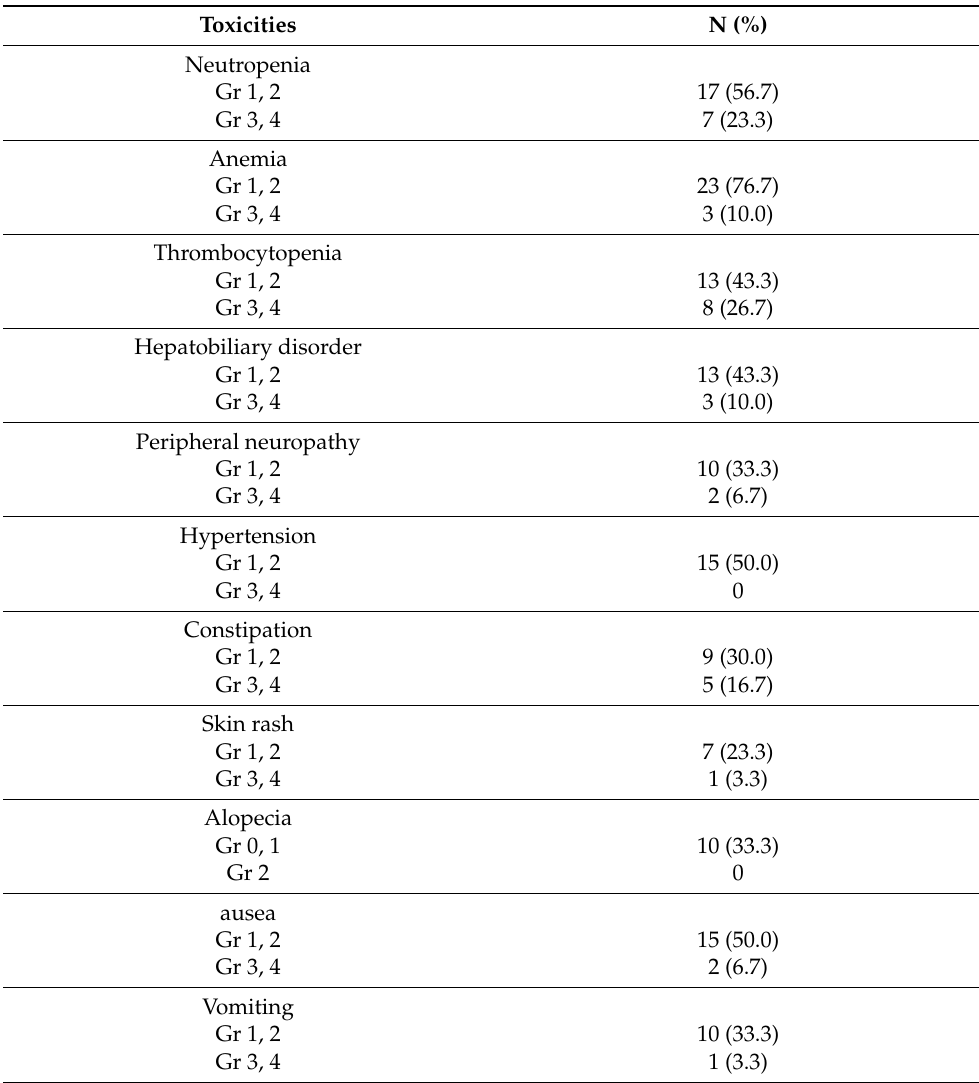
Table 4. Most severe toxicities from treatment.